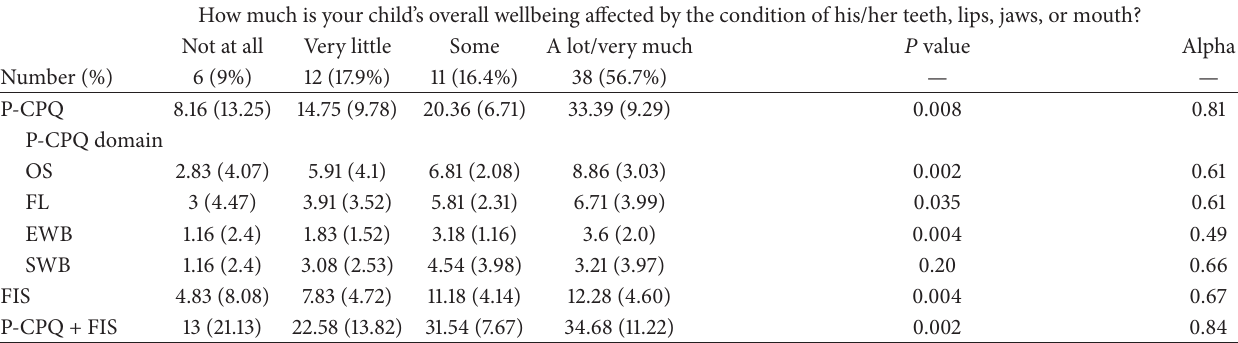
Table 1: Pretreatment Parental-Caregivers Perceptions Questionnaire (P-CPQ) scale (and subscale), Family Impact Scale (FIS), and Cronbach’s alpha.